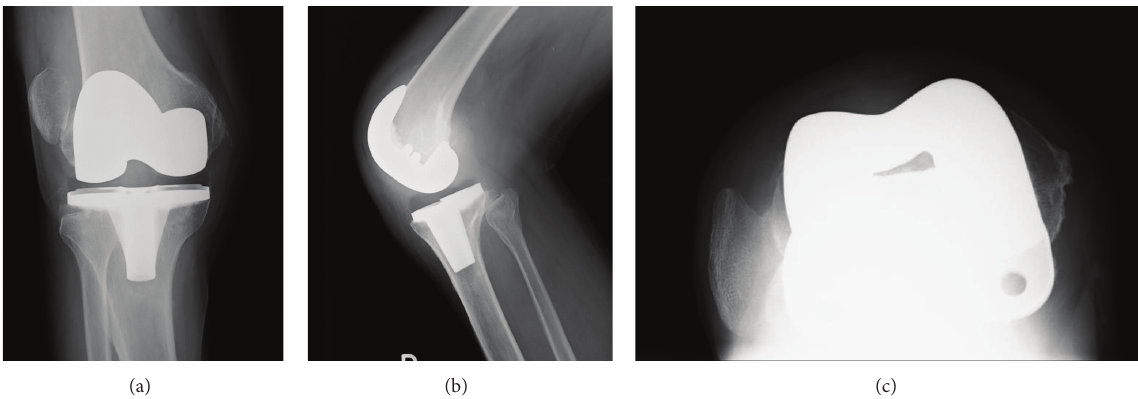
Figure 6: Final follow-up radiographs: anteroposterior view (a), lateral view (b), and skyline view (c) of right